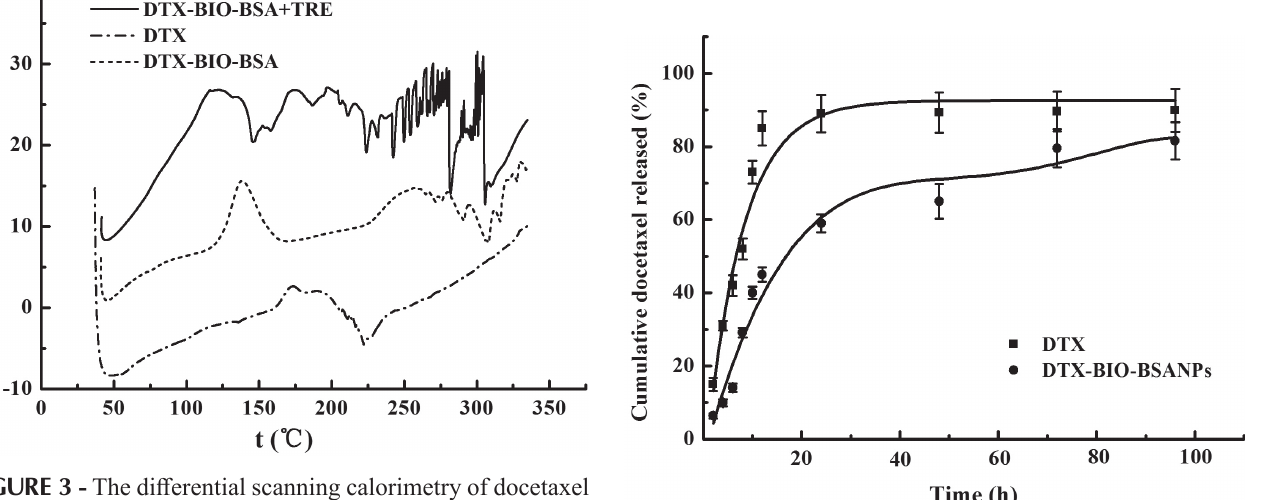
FIGURE 3 - The differential scanning calorimetry of docetaxel and freeze-dried DTX-BIO-BSA-NPs. DTX, docetaxel; DTX-BIO-BSA, docetaxel-loaded biodegradable bovine serum albumin nanoparticles with biotin decoration; DTX- BSA-BIO+trehalose (TRE), docetaxel-loaded biodegradable bovine serum albumin nanoparticles with biotin decoration and trehalose.